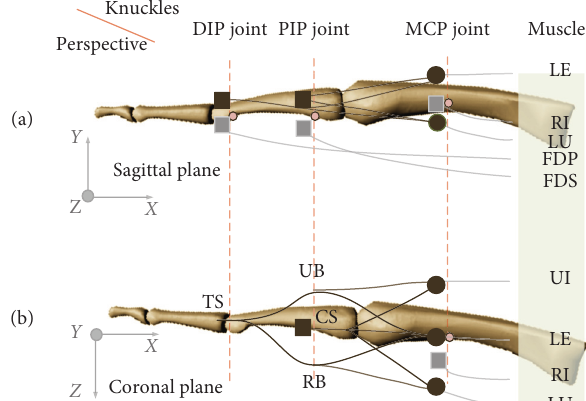
Figure 2: Theoretical model of the extensor mechanism of the finger. (a) Sagittal plane. (b) Coronal plane.